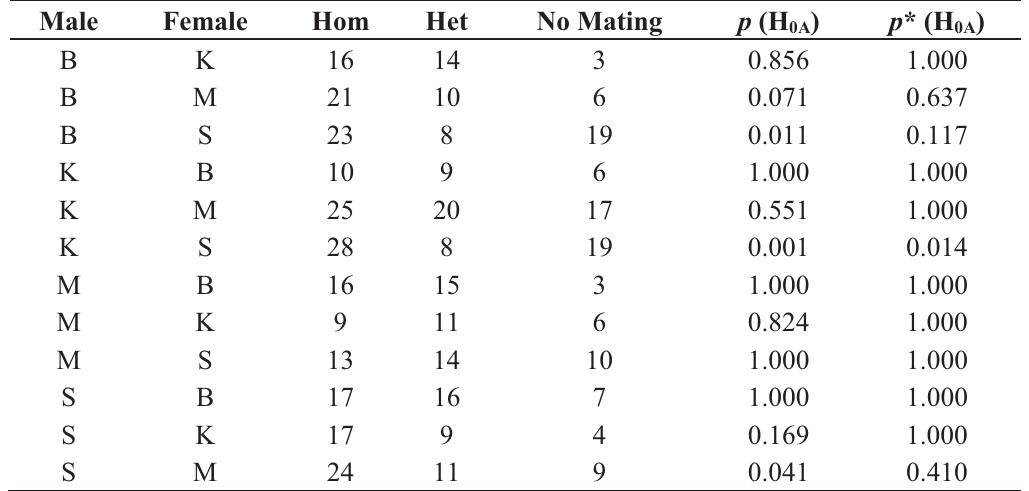
Table 5. Male choice experiment (1 male/2 females). See Table 4 for descriptions of categories.